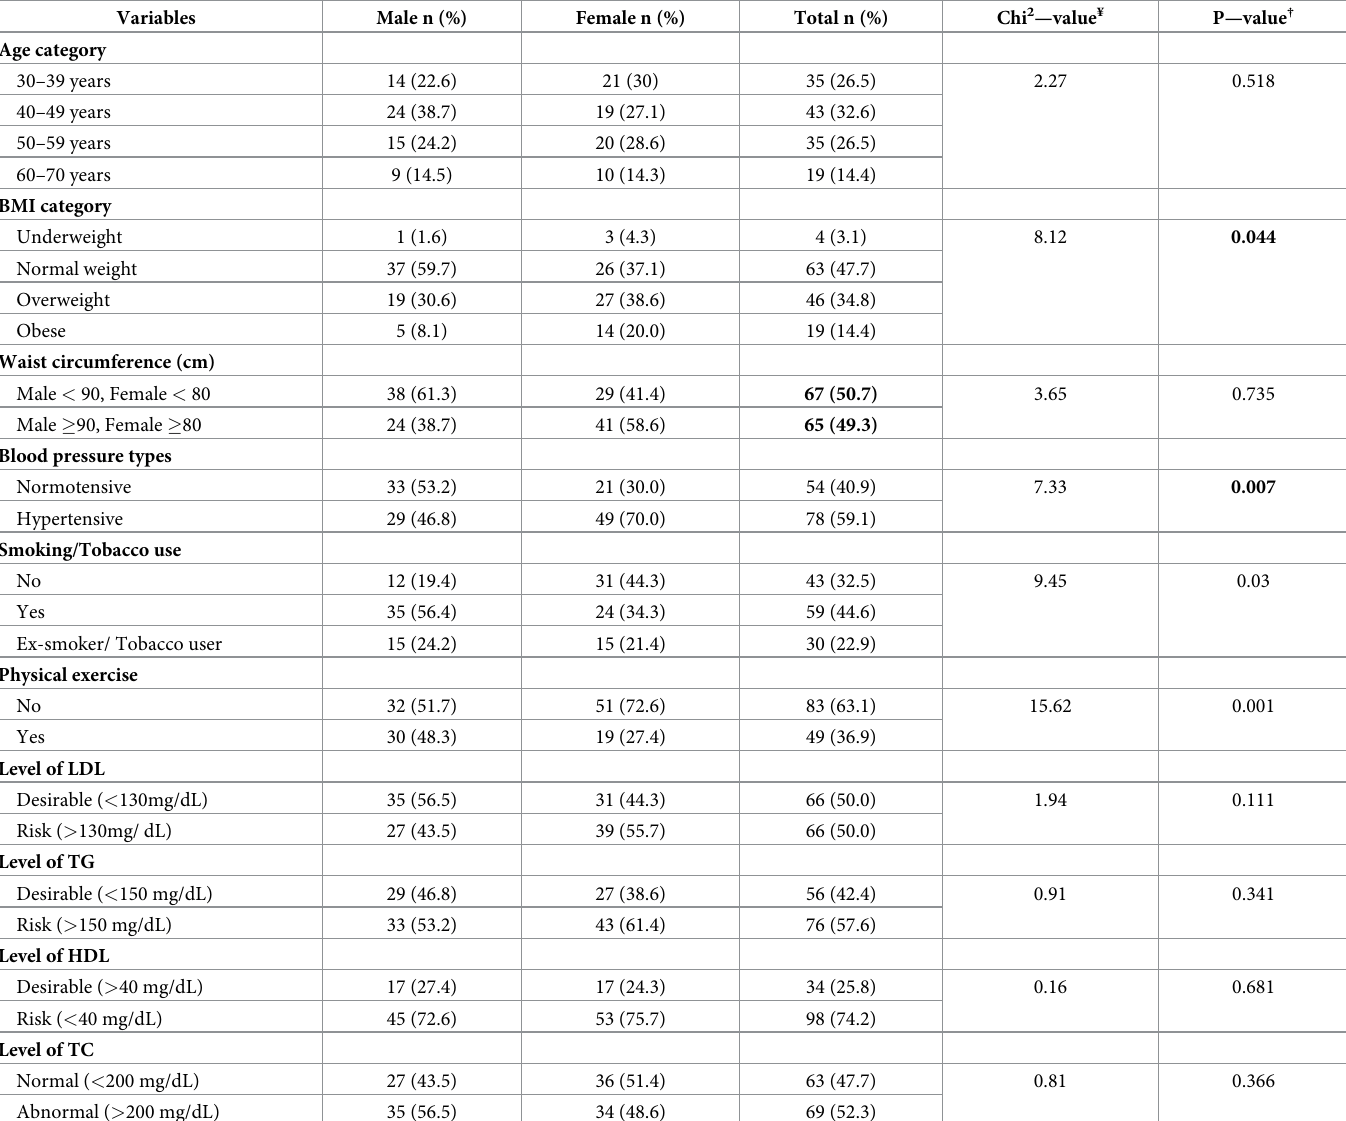
Table 2. Relationship between different clinical status and gender of the